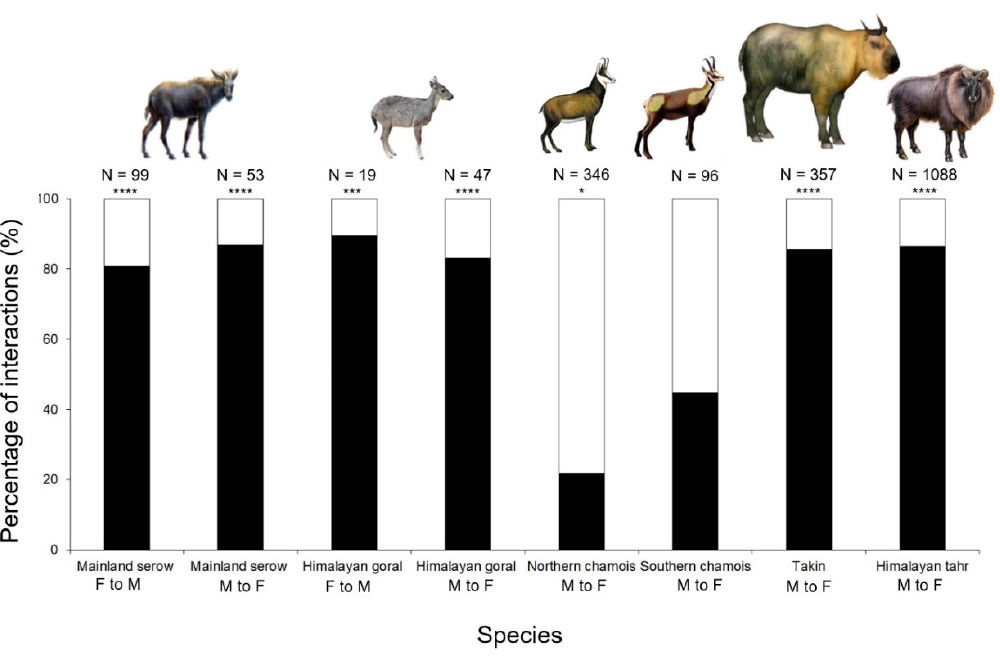
Figure 4. Direct and indirect forms of intersexual aggressive behaviour. Significance levels (Z test): * p < 0.05; *** p < 0.001; **** p < 0.0001. Black = direct forms; white = indirect forms. For sources, see Material and Methods—Data Analysis. M = male; F = female. N = number of events.